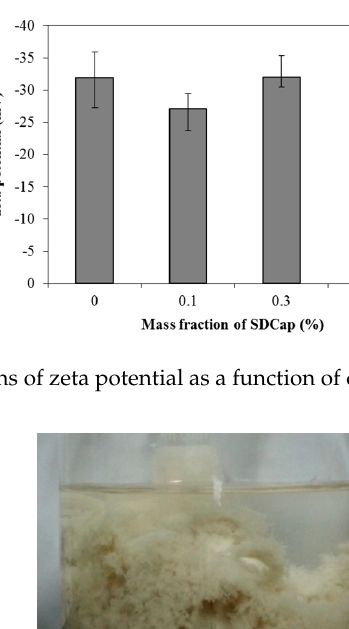
Figure 8. Clay particle size distribution in the presence of different concentration of SDCap.